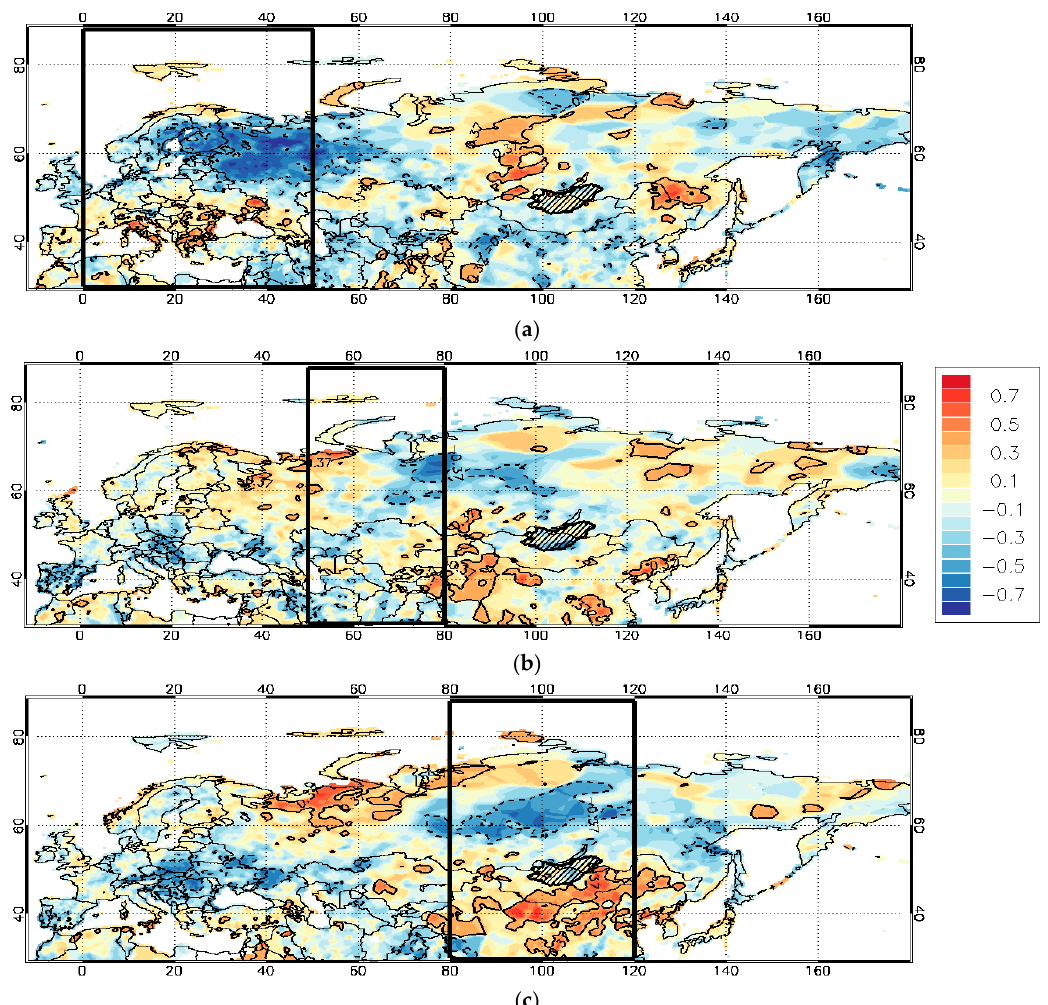
Figure 9. Correlation coefficients of E ( a ), UWS ( b ), ESM-BF ( c ) and normalized precipitation for 1996–2016. The description is the same as Figure 8.